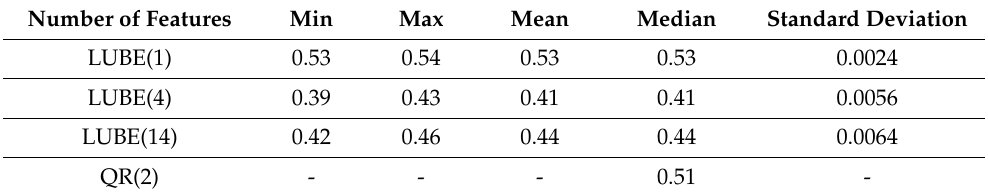
Figure 11. Number of features, 2-week average CRPS in LUBE and QR, and total gain. Table 6. Statistics of 2-week average CRPS.